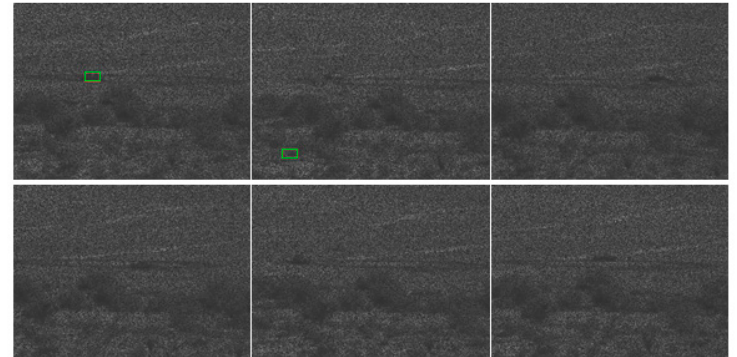
Figure 8. STAPLE tracking results for the PCE 25% case. Frames: 10, 30, 50, 70, 90, and 110 are shown here. Many frames do not have detections. The bounding boxes completely miss the targets.